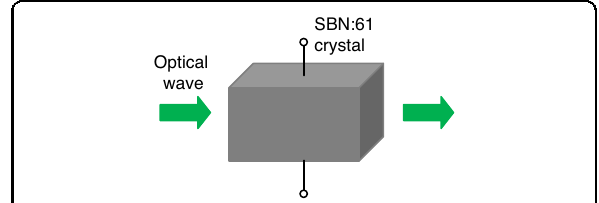
Fig. 1 System nonlinearity. Schematic of the nonlinearity generated by using photorefractive crystal in optical